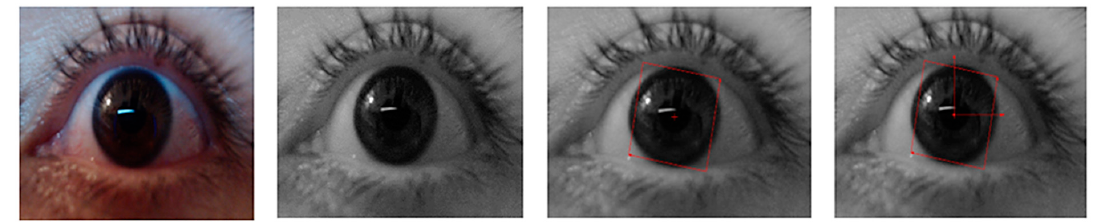
Figure 5. Real-image analysis.